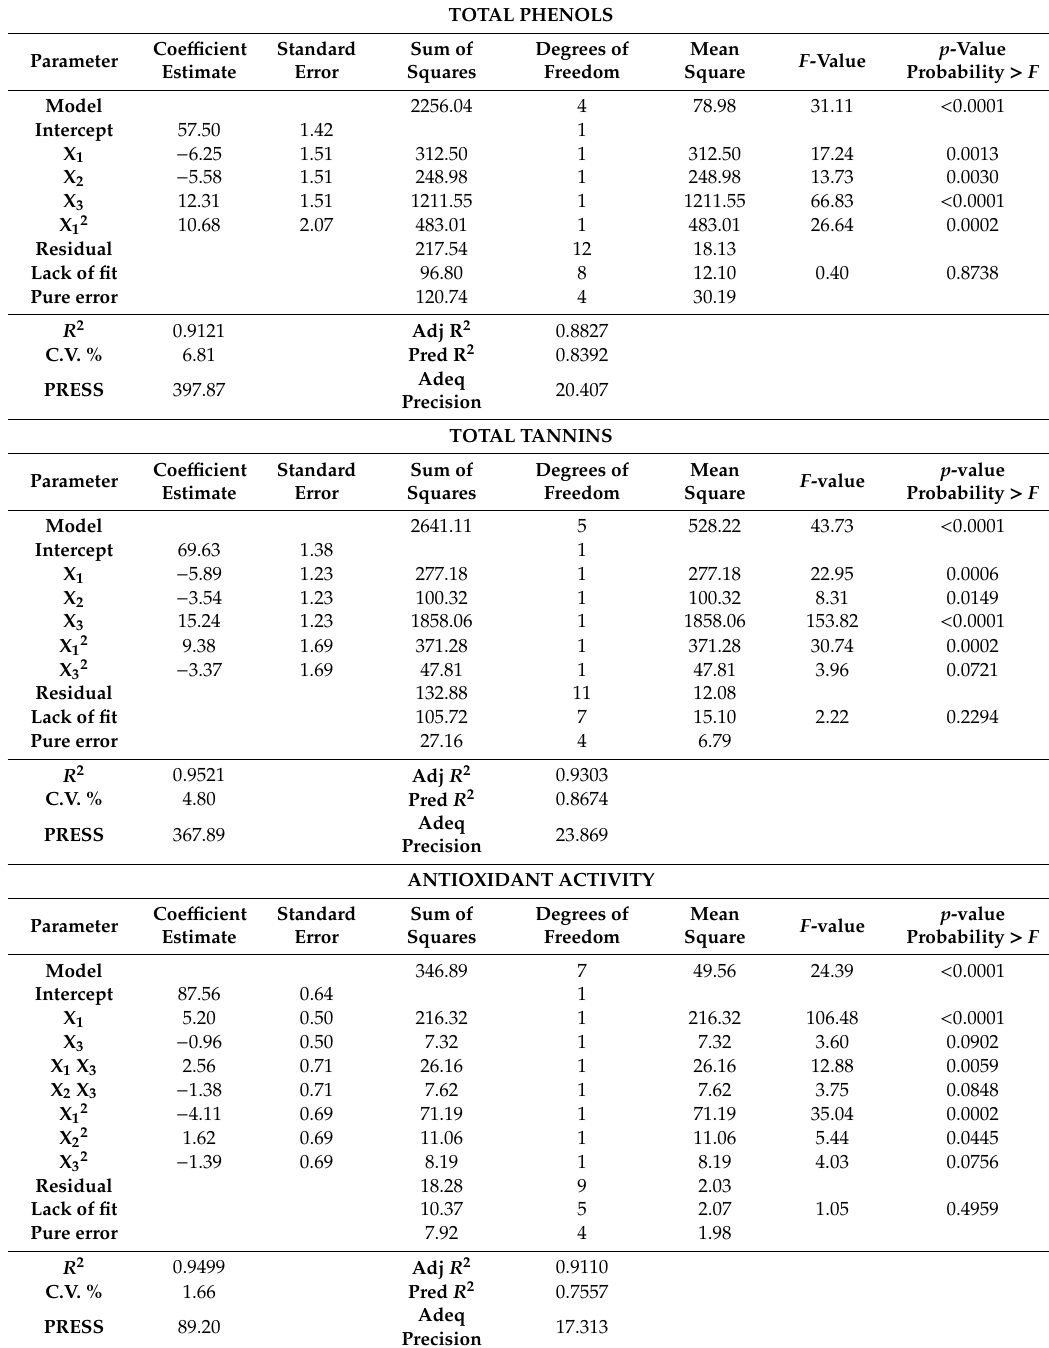
Table 4. The values of regression coe ffi cients and analysis of the models for total phenols, total tannins and antioxidant